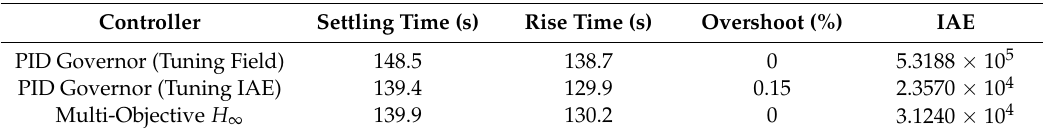
Figure 21. Closed-loop power reference tracking of the nonlinear system. Comparison between the multi-objective H ∞ robust controller and the PID Governor tuned with IAE settings and site settings: ( a ) Complete view; ( b ) Disturbance rejection in the initial stage; ( c ) Ramp command start; ( d ) Steady-state at 30 MW; ( e ) Power profile in the final stage. Table 3. Comparison between the set-point performance indexes of the different controllers.